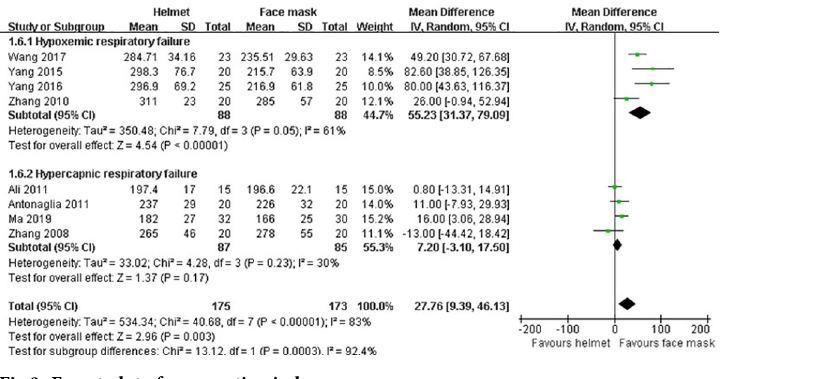
Fig 9. Forest plot of oxygenation index.